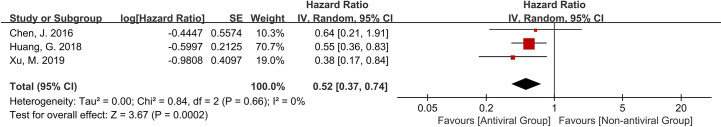
The Forest plot to compare the effect of anti-viral treatment vs. no treatment in overall survival rate.